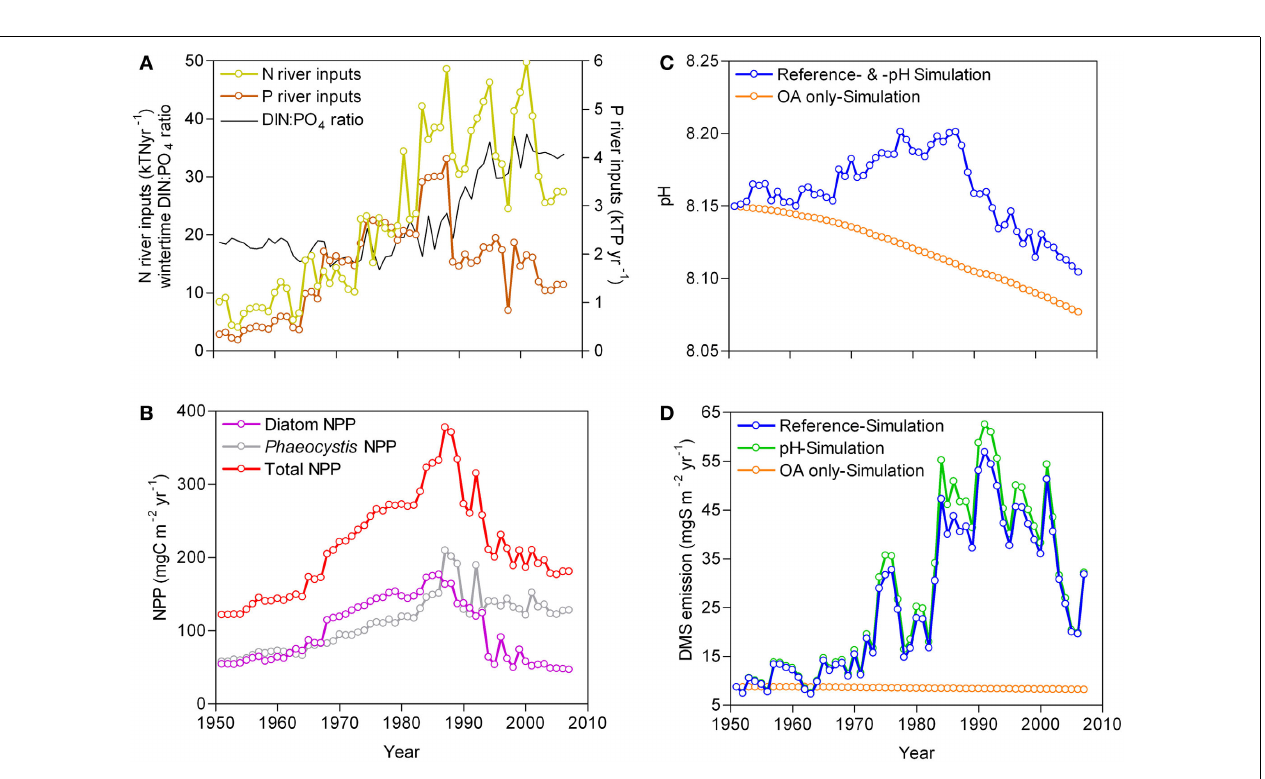
(DMS) emissions to the atmosphere in the Southern Bight of the North Sea from 1951 to 2007 given by the R-MIRO-BIOGAS model under the Reference-, pH- and Ocean acidification